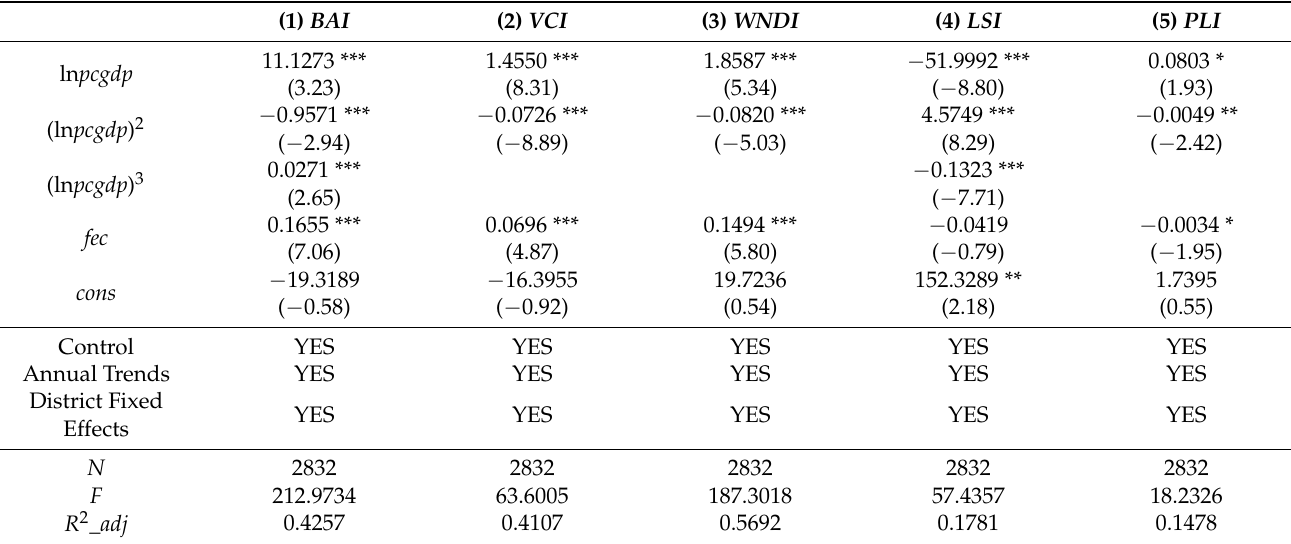
Table 3. The empirical results of the relationship between economic development and the sub- indicators of the ecological environment condition